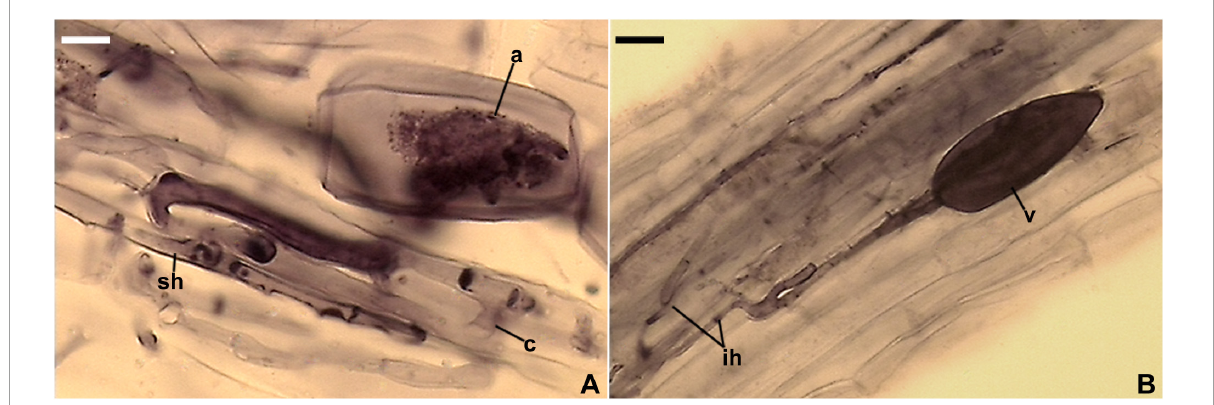
FIGURE7 Mycorrhizal structures of Entrophospora argentinensis in roots of Plantago lanceolata stained in 0.1% Trypan blue. (A) Arbuscule (a), coiled (c) and straight (sh) intraradical hyphae. (B) Vesicle (v) and intraradical hyphae (ih). (A,B) In PVLG. (A,B) Differential interference microscopy. Scale bars: (A) = 10 µ m, (B) = 20 µ